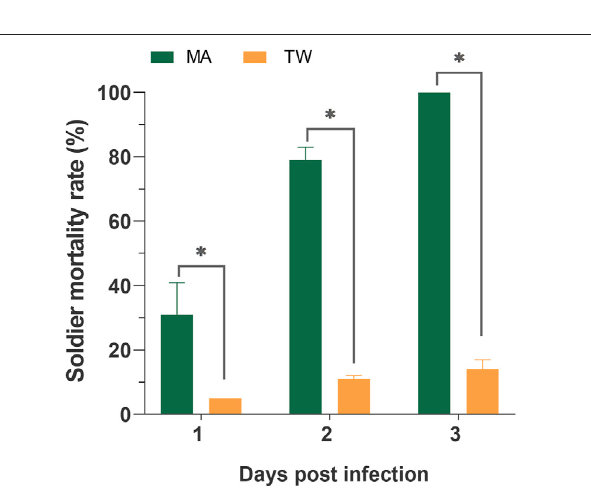
FIGURE 2 | Mortality rate of the Metarhizium anisopliae − 7 d postinfected worker and soldier Coptotermes formosanus in different compositions of worker and soldier ratio under fi xed group size ( n = 20). The numbers in the abscissa represent the numbers of infected workers and infected soldiers in each group, respectively. Differences between the mortality of the worker and soldier within group were statistically analyzed using the independent Mann – Whitney u -test ( p < 0.05). Data represent the mean ± standard error of the mean (SEM).